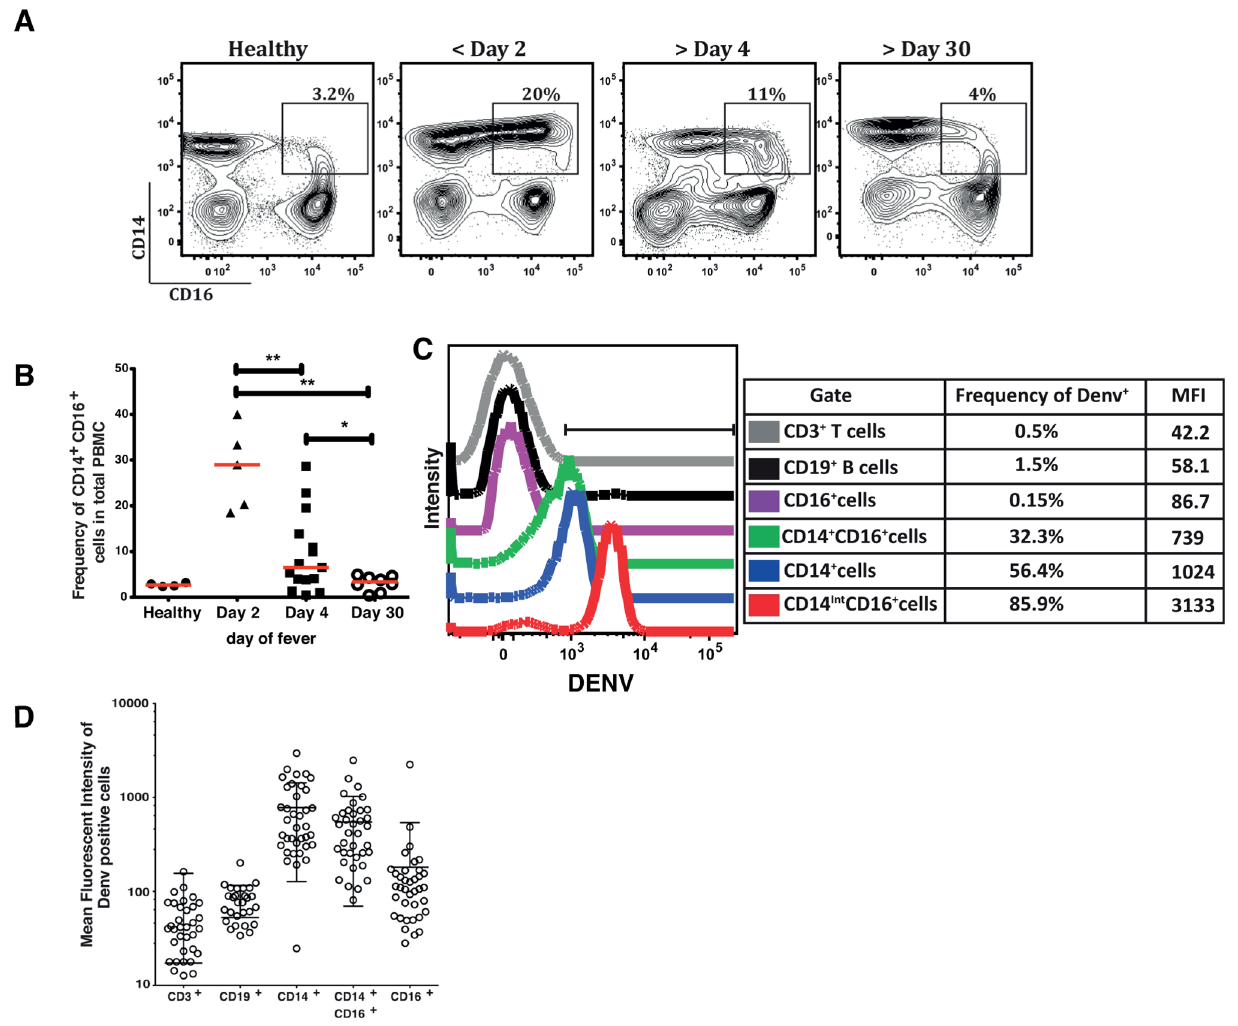
Fig 6. Transient increase in intermediate monocytes at early time points in DENV infection and monocyte infection with DENV. (A) Representative plots showing analytical multicolor flow cytometry of classical, non-classical and intermediate monocytes based on CD14 and CD16 expression ex vivo from PBMCs isolated from DENV-infected patients at indicated days of fever. (B) Cumulative frequencies of CD14+CD16+ intermediate monocytes as shown in scatter plot above. Unpaired, two-tailed t test was used for statistical analysis and P values were interpreted as * P < 0.01 and ** P < 0.001. (C) Ex vivo intracellular DENV staining was performed on total PBMCs stained with surface receptor antibodies for CD3, CD19, CD14, CD16 along with fixable viable dye to exclude dead cells. Representative histograms show intensity of DENV staining within each of the gated populations described. (D) Cumulative mean fluorescent intensities of DENV staining in the indicated cell populations (N = 31) is shown. Error bars represent Mean wth